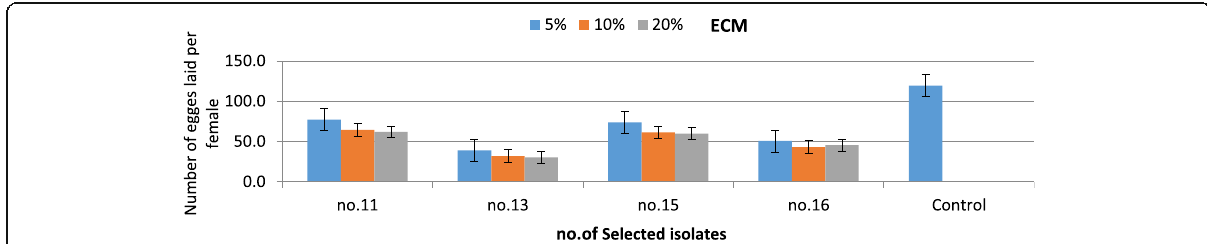
Fig. 2 Effect of different concentrations of ECM from the 4 selected isolates on number of eggs per female are represented as means (M ± SE), and statistical treatments were performed using ANOVA for differences comparing means in each concentration separately using Tukey ’ s HSD test. ANOVA parameters of 5, 10, and 20% concentrations, respectively were LSD = 1.628, 1.711, 1.509; P < 0.05